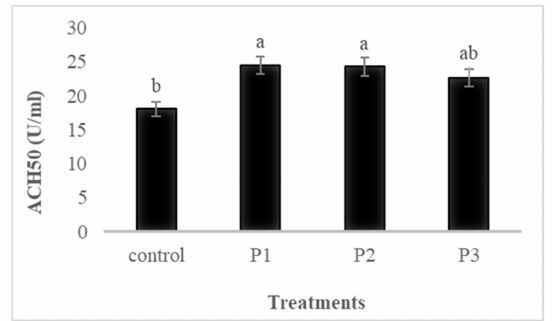
Figure 4. The effects of dietary pectin on serum alternative hemolytic complement activity (ACH50) of rainbow trout fed four experimental diets with different inclusion levels control: 0, P1: 5, P2: 10, and P3: 20 g of apple pomace derived pectin (APDP) for 30 days. Bars assigned with different superscripts are significantly different ( p < 0.05); values are presented as the mean ± SE. ( n =